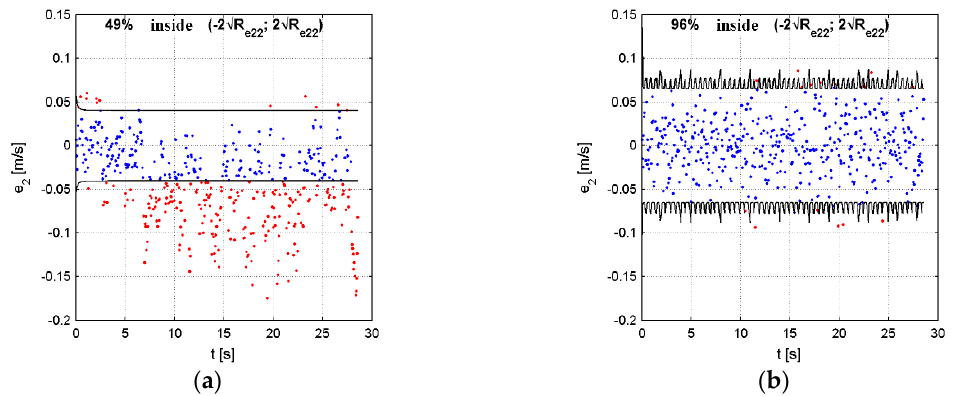
Figure 4. The e 2 element of the residual vector: ( a ) before tuning, ( b ) after Figure 4. The 𝑒 2 element of the residual vector: ( a ) before tuning, ( b ) after tuning.